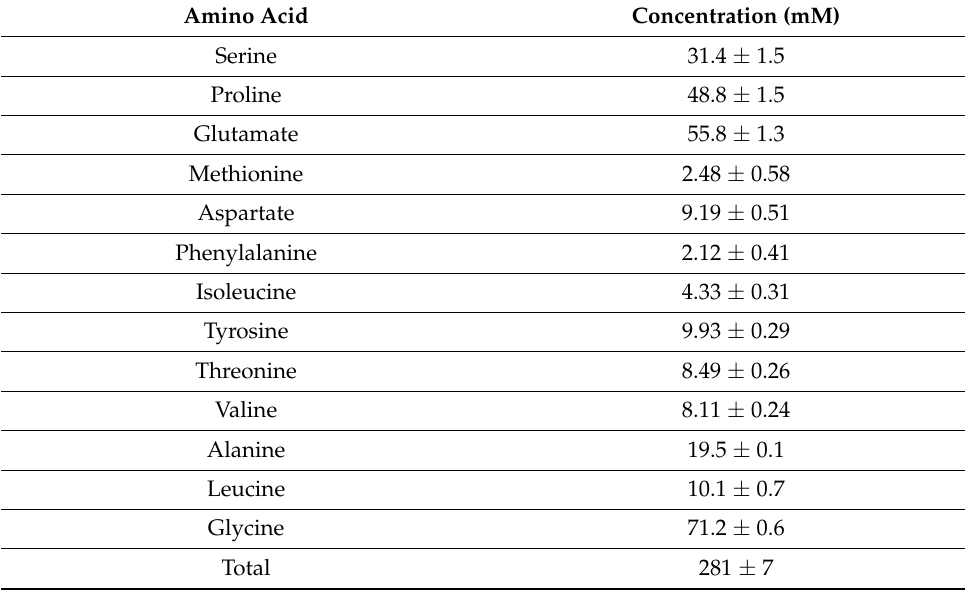
Table 3. The concentration of amino acids in the sample based on three technical